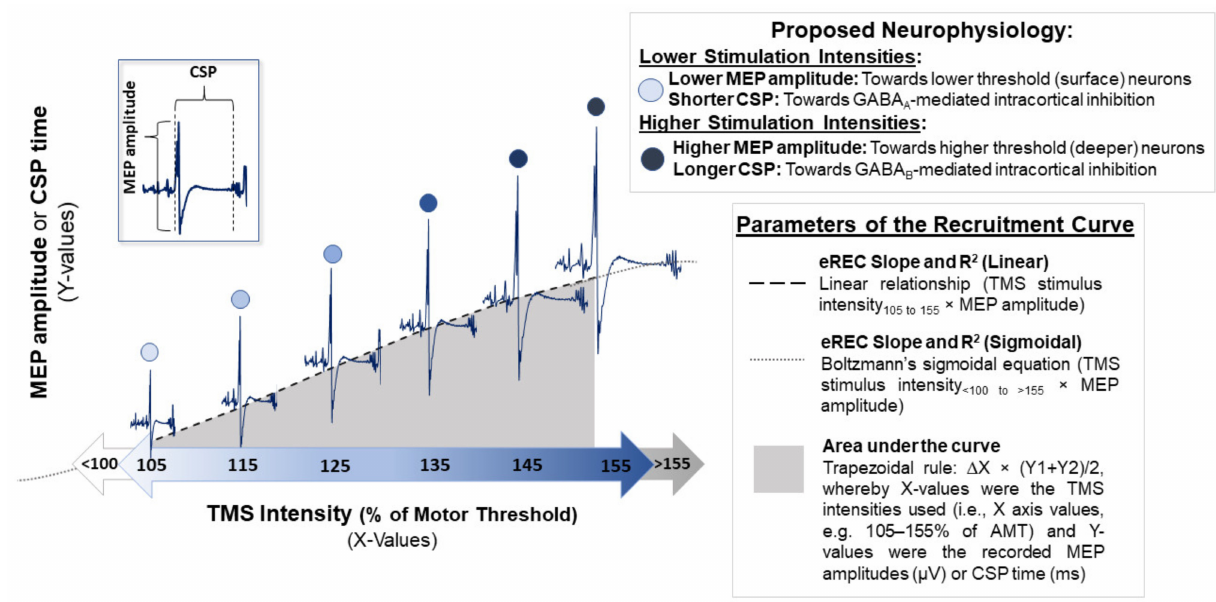
Figure 2. Parameters and Neurophysiology of the Excitatory and Inhibitory Recruitment Curves. Excitatory recruit- ment curves (eREC) are investigated by applying a varying range of transcranial magnetic stimulation (TMS) intensities [i.e., maximal stimulator output percentage (MSO%), e.g., 100–155% of Motor Threshold] and investigating the subsequent increases in motor evoked potential (MEP) amplitude (Volts). A linear or sigmoidal (Boltzmann’s) plot between MEP ampli- tude (y-values) versus the TMS intensities used (x-values) will determine the REC parameters [i.e., slope, and r-squared (R 2 )]. When muscle tone (tonic voluntary contraction) is performed by the participant during the REC assessment, the TMS variable cortical silent period (CSP), a biomarker of intracortical inhibition, can be investigated and the inhibitory REC (iREC) can be assessed. Overall excitation and inhibition are assessed by calculating the area under the curve using the trapezoid